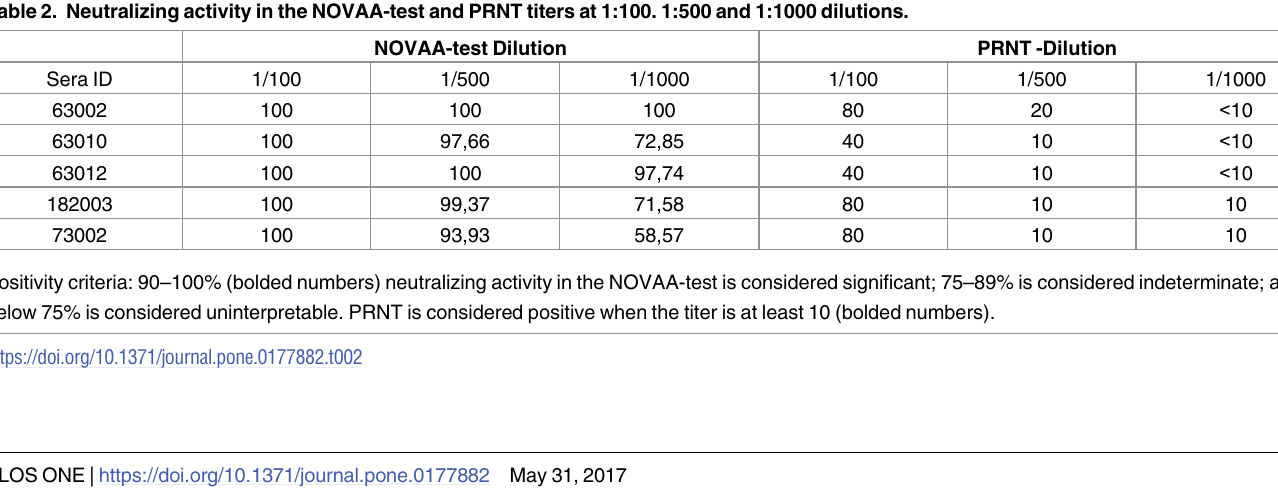
Table 2. Neutralizing activity in the NOVAA-test and PRNT titers at 1:100. 1:500 and 1:1000dilutions. NOVAA-test Dilution PRNT -Dilution